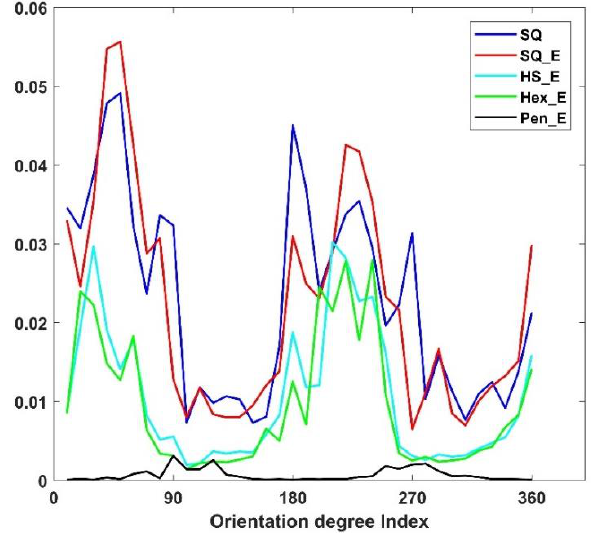
Figure 12. The variance of ANCHORs is demonstrated. The histograms of the gradient orientation with 36 bins are used and from top to bottom, there are results related to SQ, SQ_E, HS_E, Hex_E and Pen_E respectively. The ANCHOR of Pen_E (black) has the lowest variance and the SQ (deep blue) have the highest, indicate the Penrose arrangement has more robust ANCHOR in comparison to the others.